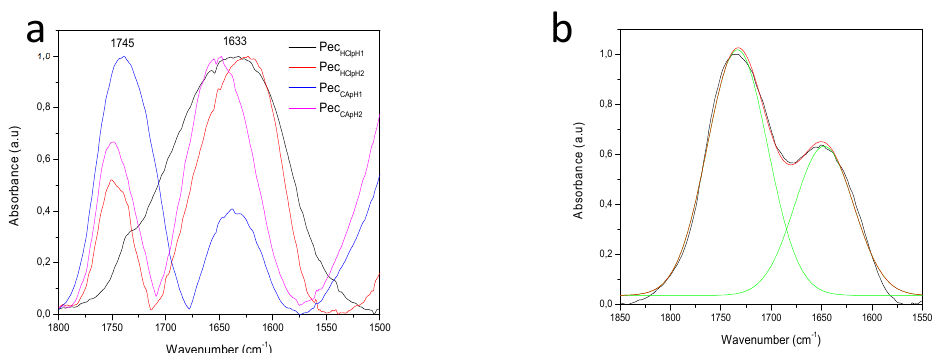
Figure 2. ( a ) Base line subtracted samples in the region 1800-1500 cm − 1 and ( b ) an example of the band deconvolution of the signals in 1747 cm − 1 (–COOCH 3 ) and 1630 cm − 1 (–COO − ) for the Pec CApH1 sample.